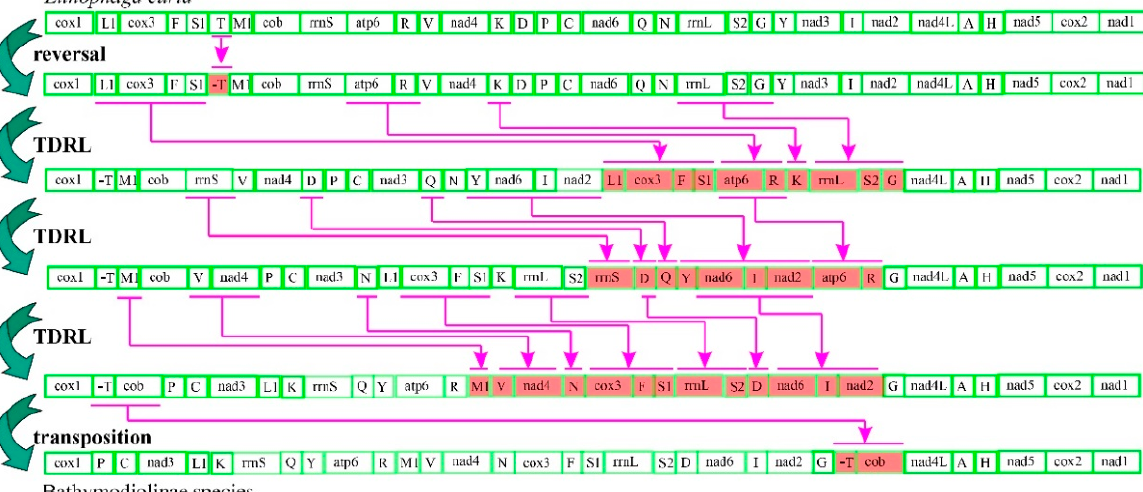
Figure 2. Putative gene rearrangement events from Lithophaga curta to Bathymodiolinae species. Purple lines and genes are colored to indicate tandem duplication random loss (TDRL) events step by step as identified by Common interval Rearrangement Explorer (CREx) analysis.